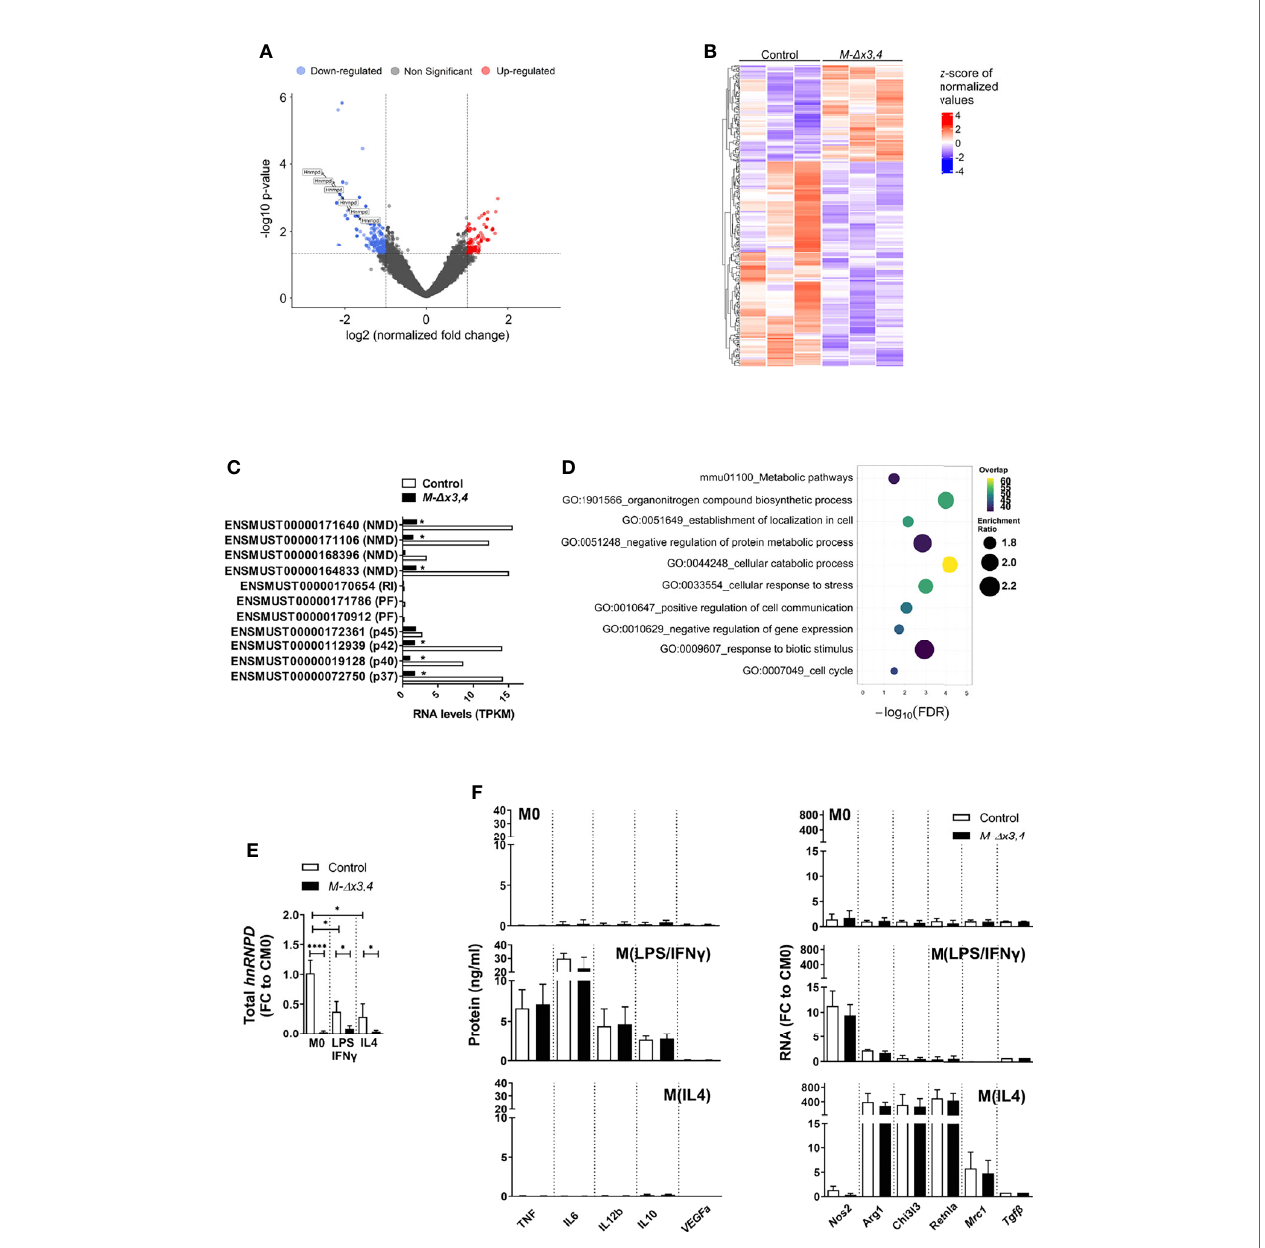
FIGURE 4 | Macrophages lacking AUF1 functions display minimal changes in their activation programs and properly acquire M1- and M2a- like phenotypes in vitro. (A) Volcano plot depicting the distribution of the adjusted P values (-Log10 (adjusted P value) and the fold changes (Log2 FC) of mRNA transcripts differing between control and M- D x3,4 BMDMs treated with LPS for 4hrs and analyzed via 3 ’ end sequencing. Signi fi cantly upregulated and downregulated transcripts are indicated by color. (B) Heatmap depicting the extend of signi fi cant changes in the levels of transcripts differing between 3 samples of LPS treated control and M- D x3,4 BMDMs. (C) Quantitation of hnRNPD RNA isoforms as derived from sequencing analyses of activated control and M- D x3,4 BMDMs. Bar graphs depict mean values of Transcripts Per Kilobase Million (TPKM) of ENSEMBL annotated RNAs for the p37,40,42 & 45 isoforms of AUF1; other protein coding fragments (PF); retained intron transcripts (RI); or RNAs yielded via NMD. (*) asterisks denote statistical signi fi cance as per the bioinformatic analyses of the datasets. (D) Functional classi fi cation of differential expressed transcripts as identi fi ed via Webgestalt (2019). Bubble plots indicate the enrichment scores and overlap of the functional categories. (E) Quantitation of total hnRNPD mRNA in Control and M- D x3,4 BMDMs (n=5) in a resting state (M0), following exposure to LPS+INF g , or IL4. Bar graphs denote mean fold changes (FC ± SD) in exon 3 containing mRNAs relative to resting control values (CM0) as assessed via qRT-PCR. (F) Quantitation of factors marking the classical or the alternative polarization of macrophages in control and M- D x3,4 BMDMs (n=10) either in a resting state (M0), following exposure to LPS+IFN g , or IL4. Bar graphs denote mean values ( ± SD) of secreted proteins assessed via Cytometric bead arrays; or mean fold changes (FC) in mRNAs relative to resting control values (CM0) as assessed via qRT-PCR. In all bar graphs, (*, ****) denote p values ≤ 0.05 or ≤ 0.00001 respectively as determined via unpaired Student ’ s